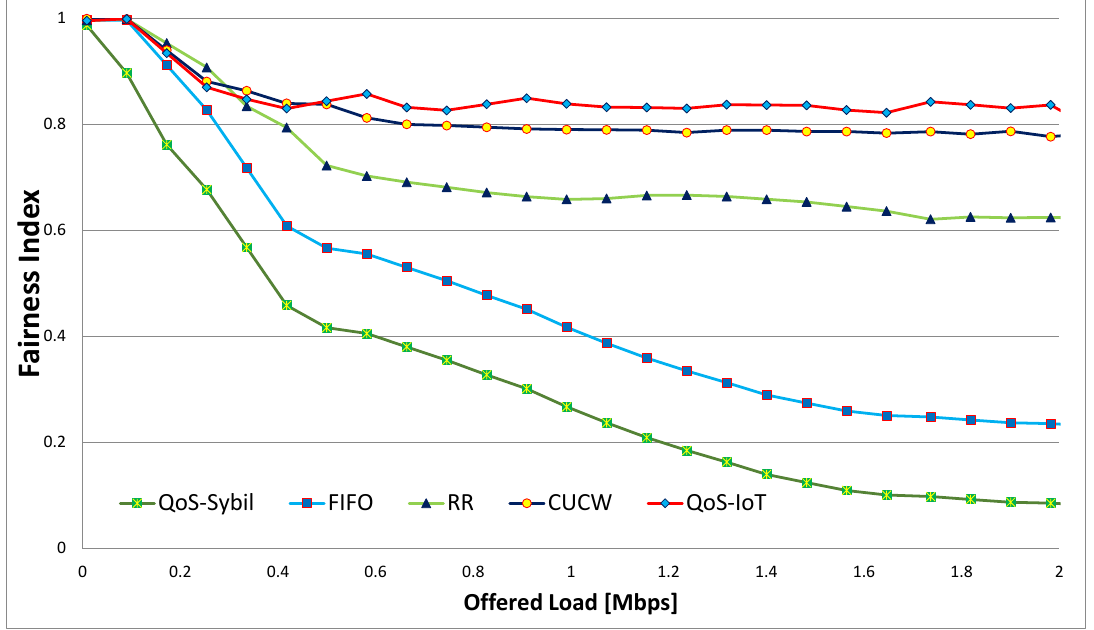
Figure 6. Fairness Indices affected by Sybil